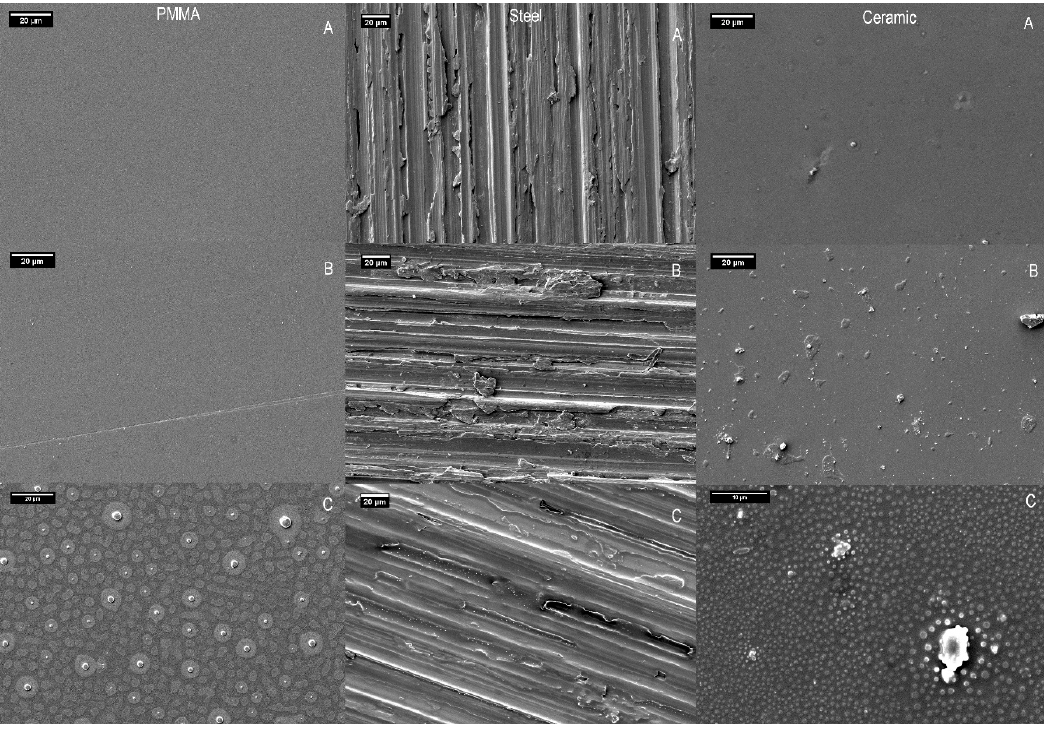
Figure 1. SEM images of poly (methyl methacrylate) (PMMA), steel (Rough) and ceramic surface samples. ( A ) Sterile control; ( B ) dH 2 O; ( C ) biocide.